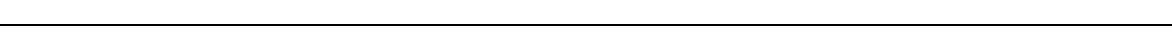
Fig. 4 UV-light-induced phosphorylation of NELFE by MK2 leads to 14-3-3 binding. a Identi fi cation of p38-dependent NELFE interaction partners after UV light. SILAC-labeled U2OS cells expressing GFP-NELFE were mock-treated or irradiated with UV light. Cells were lysed and protein extracts were incubated with GFP Trap agarose. Enriched proteins were resolved on SDS-PAGE and digested in-gel into peptides. Peptides were extracted from gel and analyzed by LC-MS/MS. The scatter plot shows the logarithmized SILAC ratios of proteins quanti fi ed in the pull down. The color coding indicates the density. b NELFE interaction with 14-3-3 after UV light is p38- and MK2/3/5-dependent. U2OS cells expressing Flag-Strep-14-3-3 or an empty vector were mock-treated, irradiated with UV light or pretreated with the p38 or MK2/3/5 inhibitor, and then irradiated with UV light. Cells were lysed and protein extracts were incubated with StrepTactin sepharose. Enriched proteins were resolved by SDS-PAGE and selected proteins were detected with the indicated antibodies. c NELFE interaction with GST-14-3-3 is abolished in p38 and MK2 knockdown cells. U2OS cells were transfected with non-targeting, p38, or MK2-targeting siRNA and then irradiated with UV light. Cells were lysed and protein extracts were incubated with recombinant GST-14-3-3. Enriched proteins were resolved by SDS-PAGE and NELFE was detected using a speci fi c antibody. d NELFE is phosphorylated after UV light on a 14-3-3-binding motif. GFP-NELFE was pulled down using GFP Trap agarose. Phosphorylation of NELFE was detected using antibodies recognizing the 14-3-3 motif. NELFE knockdown was used as control. e NELFE interacts with 14-3-3 after inhibition of P-TEFb. U2OS cells were treated with the p38 inhibitor or P-TEFb inhibitor 5,6-dichloro-1- β - D -ribofuranosylbenzimidazole (DRB) and then irradiated with UV light. After cell lysis, protein extracts were incubated with the recombinant GST-14-3-3. f Dynamics of NELFE interaction with 14-3-3 after UV light. U2OS cells were exposed to UV light and left to recover for the indicated time points. After cell lysis, protein extracts were incubated with the recombinant GST-14-3-3. g NELFE interaction with 14-3-3 is partially dependent on the NER machinery. U2OS cells were transfected with a non-targeting siRNA or siRNA targeting XPC or CSB and then irradiated with UV light. After cell lysis, protein extracts were incubated with the recombinant